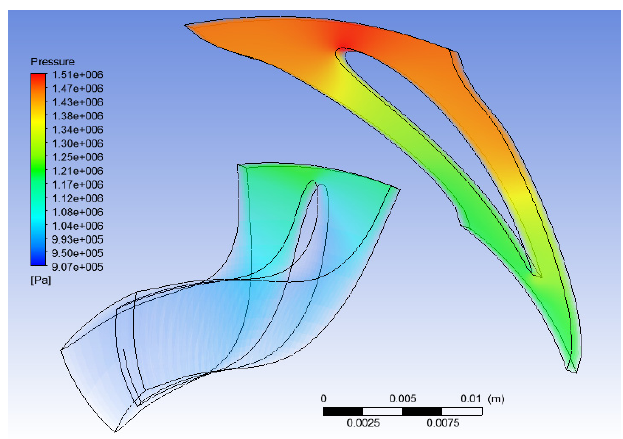
Figure 21. CFD study results: Pressure (R134a).